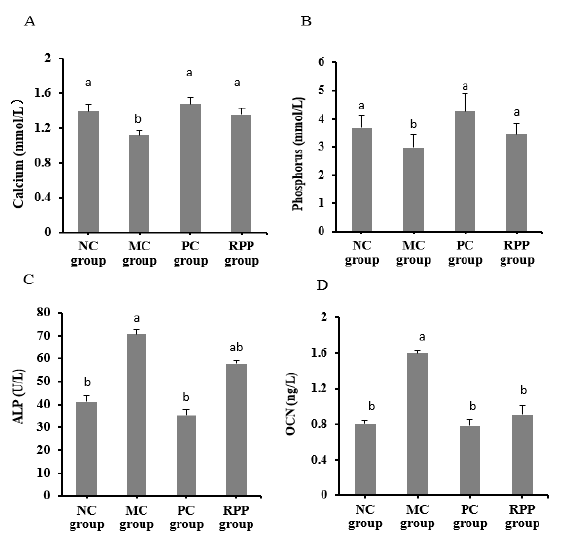
Figure 5. Effect of RPP on blood biochemical parameters in rats. Serum levels of ( A ) calcium, ( B ) phosphorus, ( C ) alkaline phosphatase (ALP), and ( D ) osteocalcin(OCN) of rats in each group were determined. Groups with different letters are significantly different ( p < 0.05).